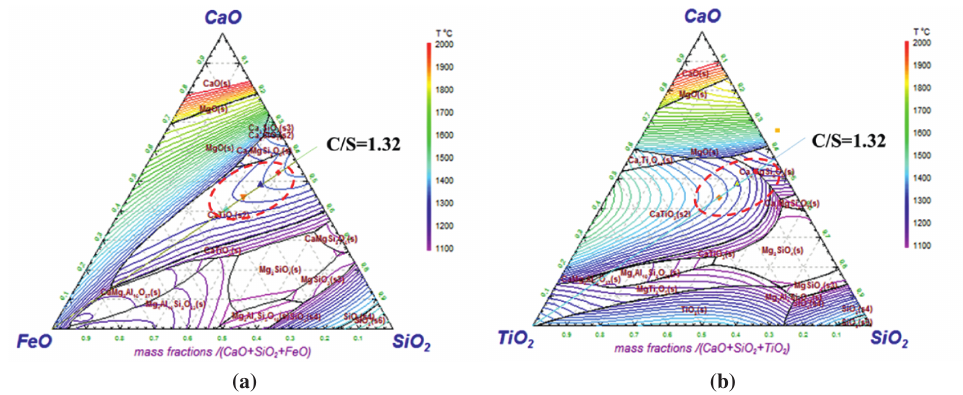
Figure 6: Phase diagrams of SiO 2 -CaO-MgO-Al 2 O 3 -FeO-TiO 2 slag system. (a) TiO 2 = 10 wt%; (b) FeO = 15